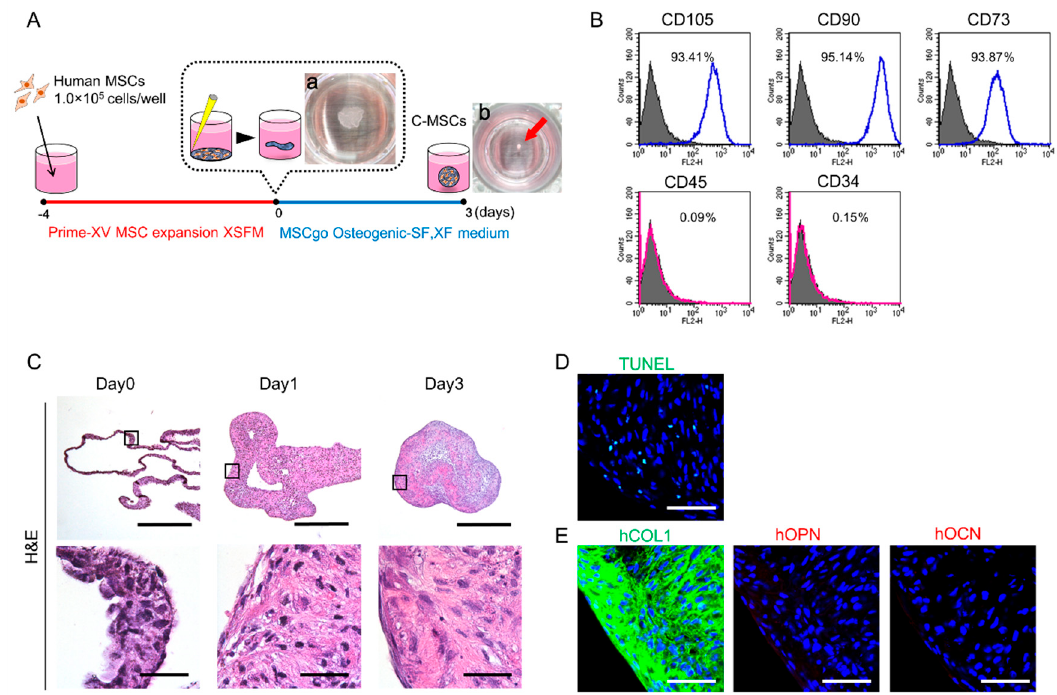
Figure 1. Generation of mesenchymal stem cell (MSC) / extracellular matrix (ECM) complexes (C-MSCs) in xeno-free conditions. ( A ) Schematic image of C-MSCs generation in xeno-free culture conditions. a: Macroscopic image of cellular sheet on day 0. b: Macroscopic image of cell clumps on day 3. ( B ) Cells cultured with Prime-XV MSC expansion XSFM for 4 days were isolated and their surface marker expression levels were monitored by flow cytometry. Open histograms with blue or red lines indicate CD105-, CD90-, CD73-, CD45-, or CD34-positive cells. The isotype-matched control IgG is shown as a solid histogram. ( C ) C-MSCs were cultured in floating conditions until the end of the culture period and were stained with H&E. The upper panels show lower magnification (Bar = 500 µ m), and magnified images in the boxed regions are shown in the lower panels (Bar = 50 µ m). ( D and E ) C-MSCs were cultured for 3 days in xeno-free conditions. Serial sections were stained with TUNEL (green) ( D ) or bone matrix-related proteins, including COL1 (green), OPN (red), and OCN (red) ( E ), respectively. Nuclei (blue) were counter-stained with DAPI. Bar = 50 µ m. All graphs and images are representative of three independent experiments.